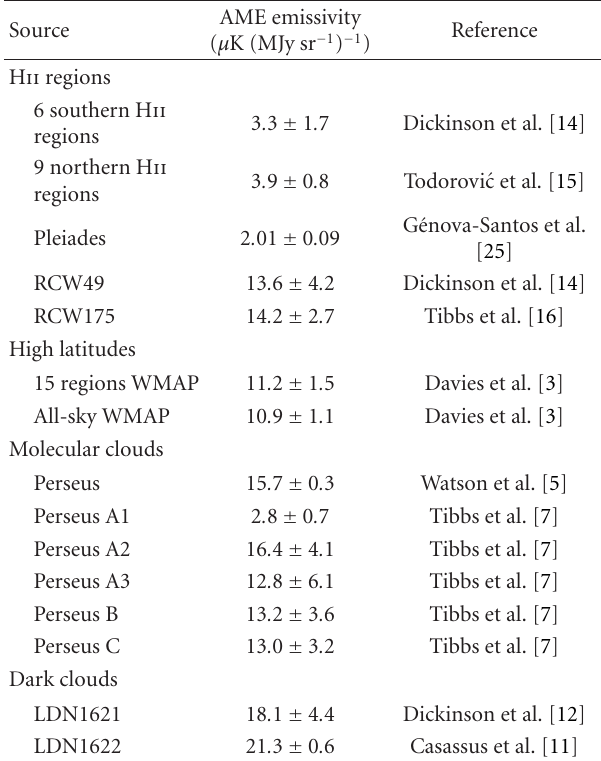
Table 1: Sample of AME emissivity values for AME detections in a variety of di ff erent environments computed relative to the intensity of the 100 μ m